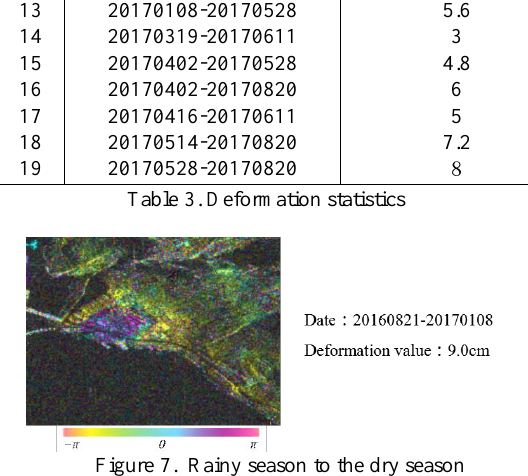
Figure 7. Rainy season to the dry season